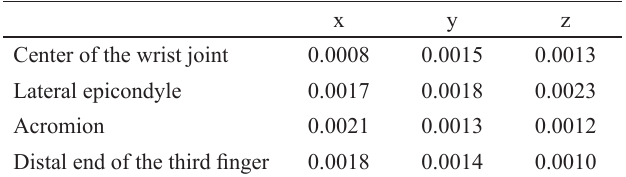
Table 2. Standard deviation of all points’ positions across 10 digiti- zations where x-axis represents the posterior-anterior direction, the y-axis the medial-lateral direction, and the z-axis the caudal-cranial direction